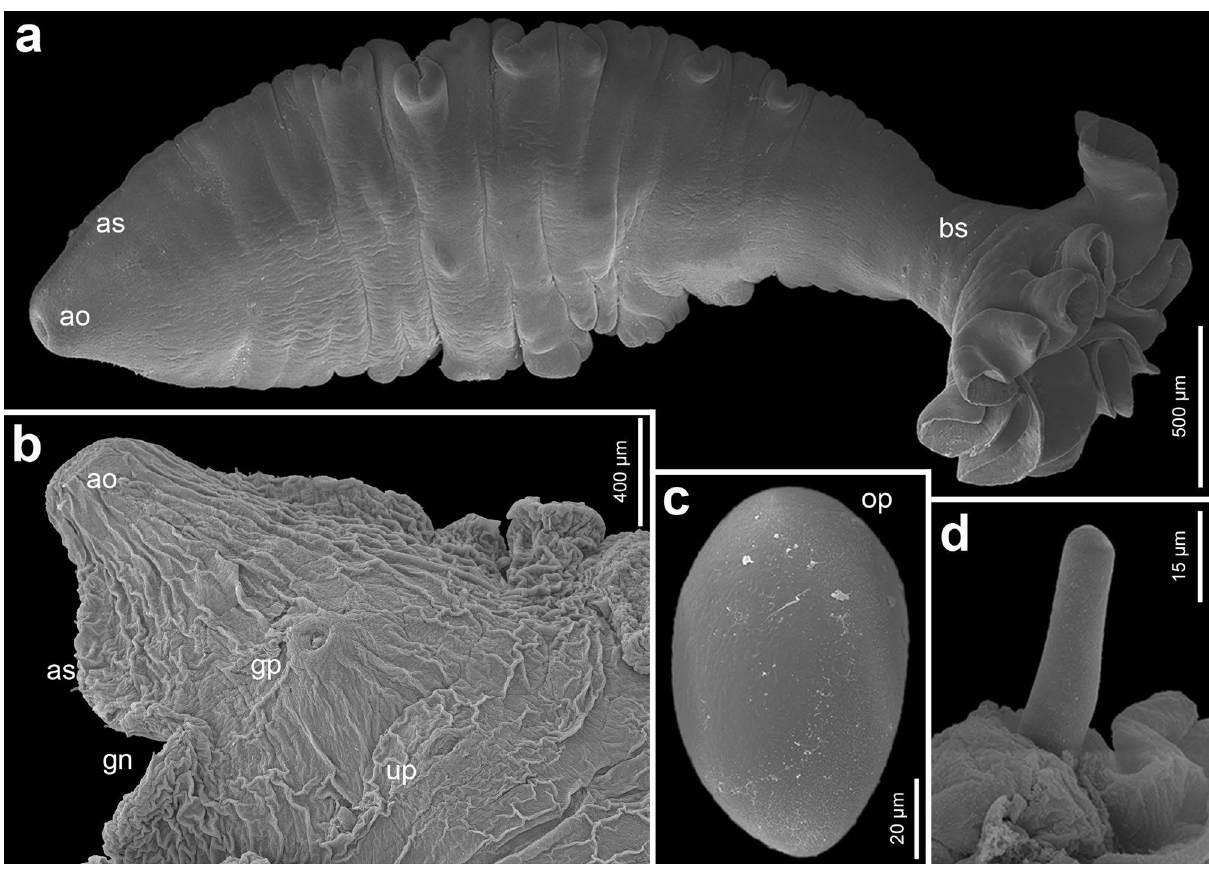
Figure 3. Scanning electron micrographs of Gyrocotyle sp. genotype 1 ex Chimaera phantasma (Taiwan). Ventral view of a juvenile specimen TW12-3; note the distribution of body spines restricted near the rosette, lateral plication, and weakly developed genital pores ( a ). The anterior body part of an adult TW12-3 specimen ( b ), intrauterine egg with smooth surface and shallow operculum ( c ), detail of an acetabular spine ( d ). ao acetabular opening, as acetabular spines, bs body spines, gn genital notch, gp genital papilla, op operculum, up uterine Gyrocotyle sp. genotype 2 is characterised by a large acetabulum and the rosette is not wider than the maxi- mum body width. The acetabular spines are numerous and the body spines are small, with dorsal spines distrib- uted on the posterior half of the body and near the lateral margins towards the acetabulum, whereas the ventral body spines are restricted to near the rosette; anterolateral spines (posterior to the acetabular spines) are also present. The testicular field reaches one-half of the uterus, the ejaculatory duct is coiled, and the uterine sac is middle-sized (Fig. 2c,d). Gyrocotyle sp. genotype 3 possesses a small acetabulum and the rosette is not wider than the maximum body width. The acetabular spines are less numerous, body spines are large and distributed over the whole body sur- face. They are more numerous on the dorsal than on the ventral side, and their density is highest on the funnel, decreasing towards the acetabulum. The testicular field reaches one fourth of the uterus, the ejaculatory duct is straight, and the uterine sac is large (Fig. 2e,f). The single specimen of Gyrocotyle sp. genotype 4 markedly differs from the specimens of all the genotypes described above by its lateral margins with few deep folds, numerous acetabular spines, a relatively narrow fun- nel and rosette, and the ovary being far from both the dorsal opening and the posterior body margin (Fig. 2g). Gyrocotyle rugosa from Callorhinchus callorynchus off Argentina is typified by possessing an elongated body with crenulate lateral margins, a small rosette, a weakly developed uterine sac, a branched uterus, a V-shaped ovary and embryonated intrauterine eggs (Fig. 2h).